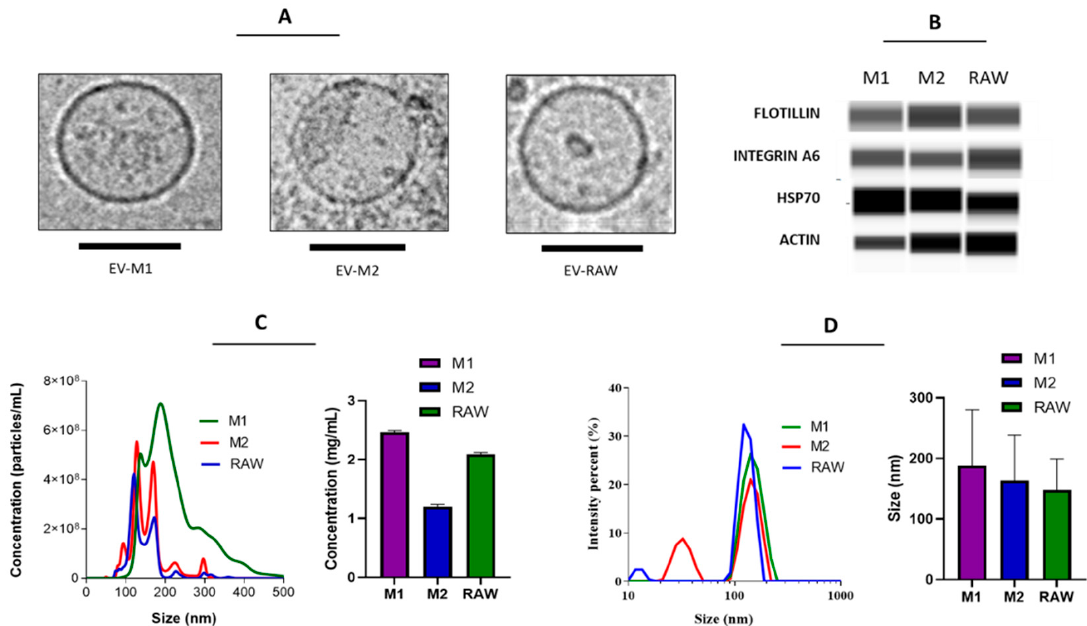
Figure 1. Characterization of EVs derived from RAW 264.7 cells as well as M1- and M2-polarized macrophages. Representative ( A ) cryo-EM micrograph, ( B ) capillary electrophoresis, ( C ) NTA, and ( D ) DLS. Scale bars are 100 nm.